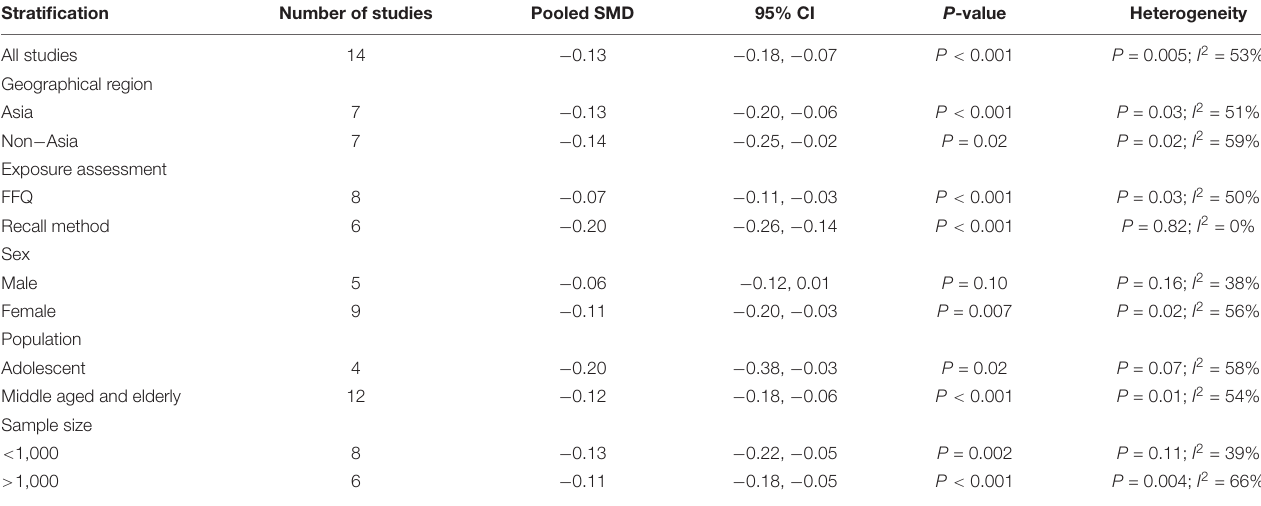
TABLE 3 | Subgroup analysis for SMD of dietary vitamin A intake in depression vs. control